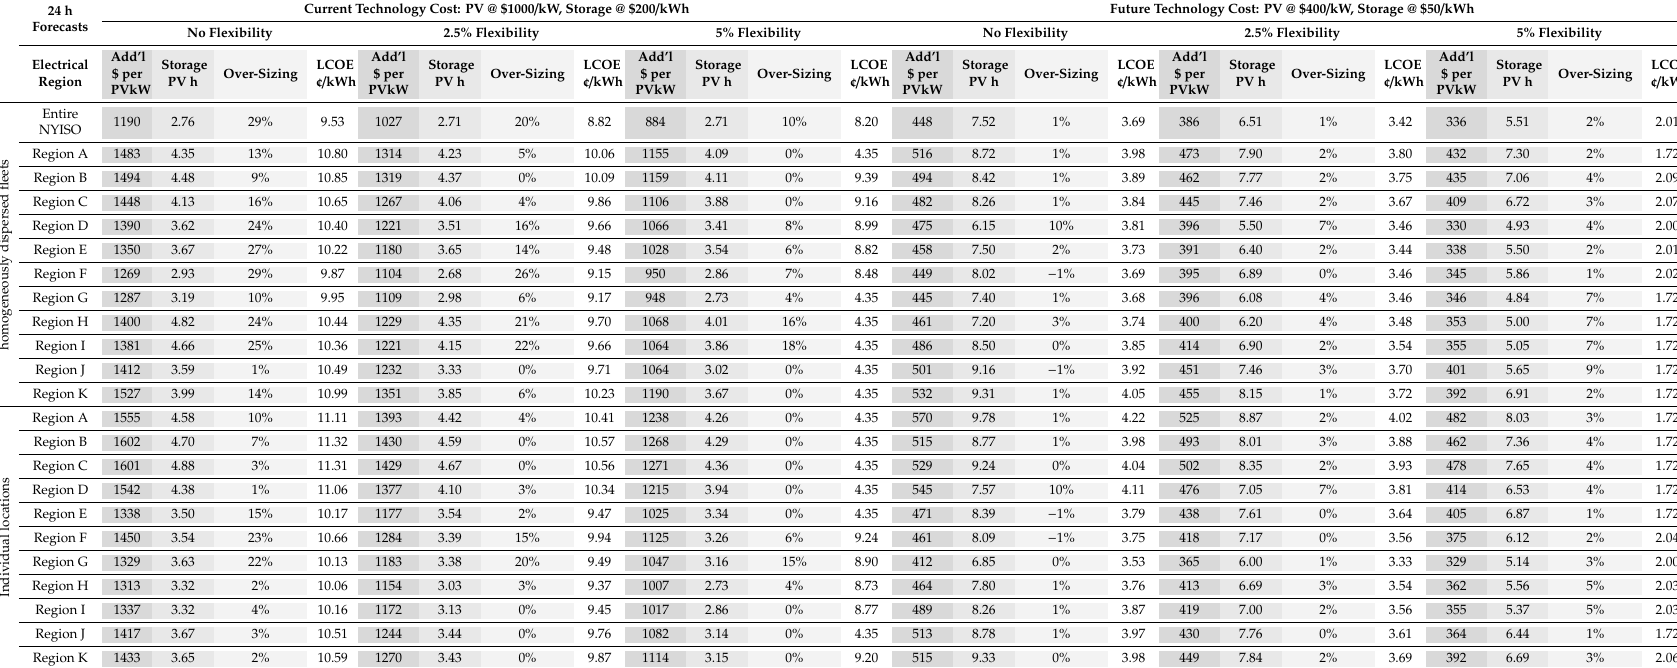
Table A7. Twenty-four-hours-ahead firm forecast results applying smart